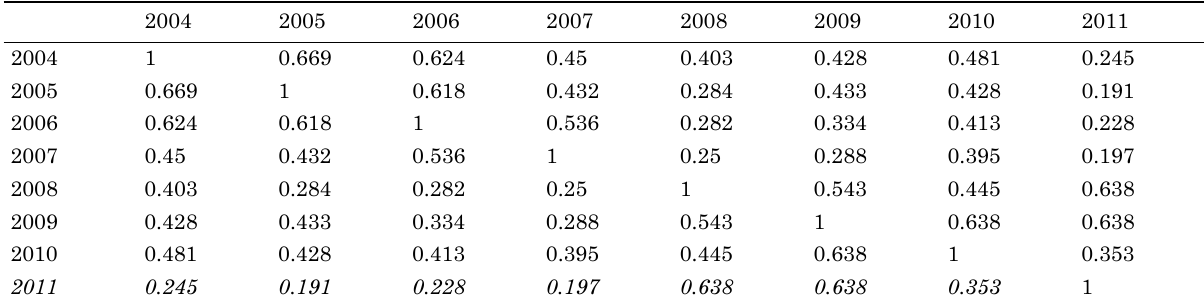
Table 2. Transaction density correlations in respective